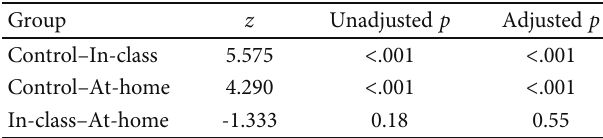
Table 5: Posthoc analysis among three